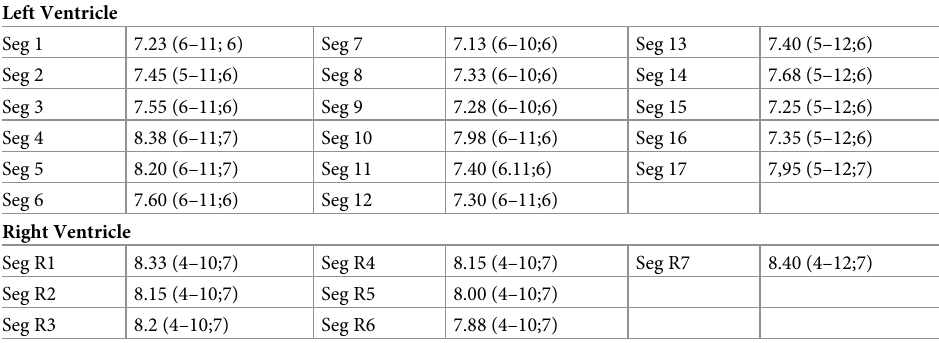
Table 1. Overview over the image quality score in all analyzed left and right ventricular segments. Left Ventricle